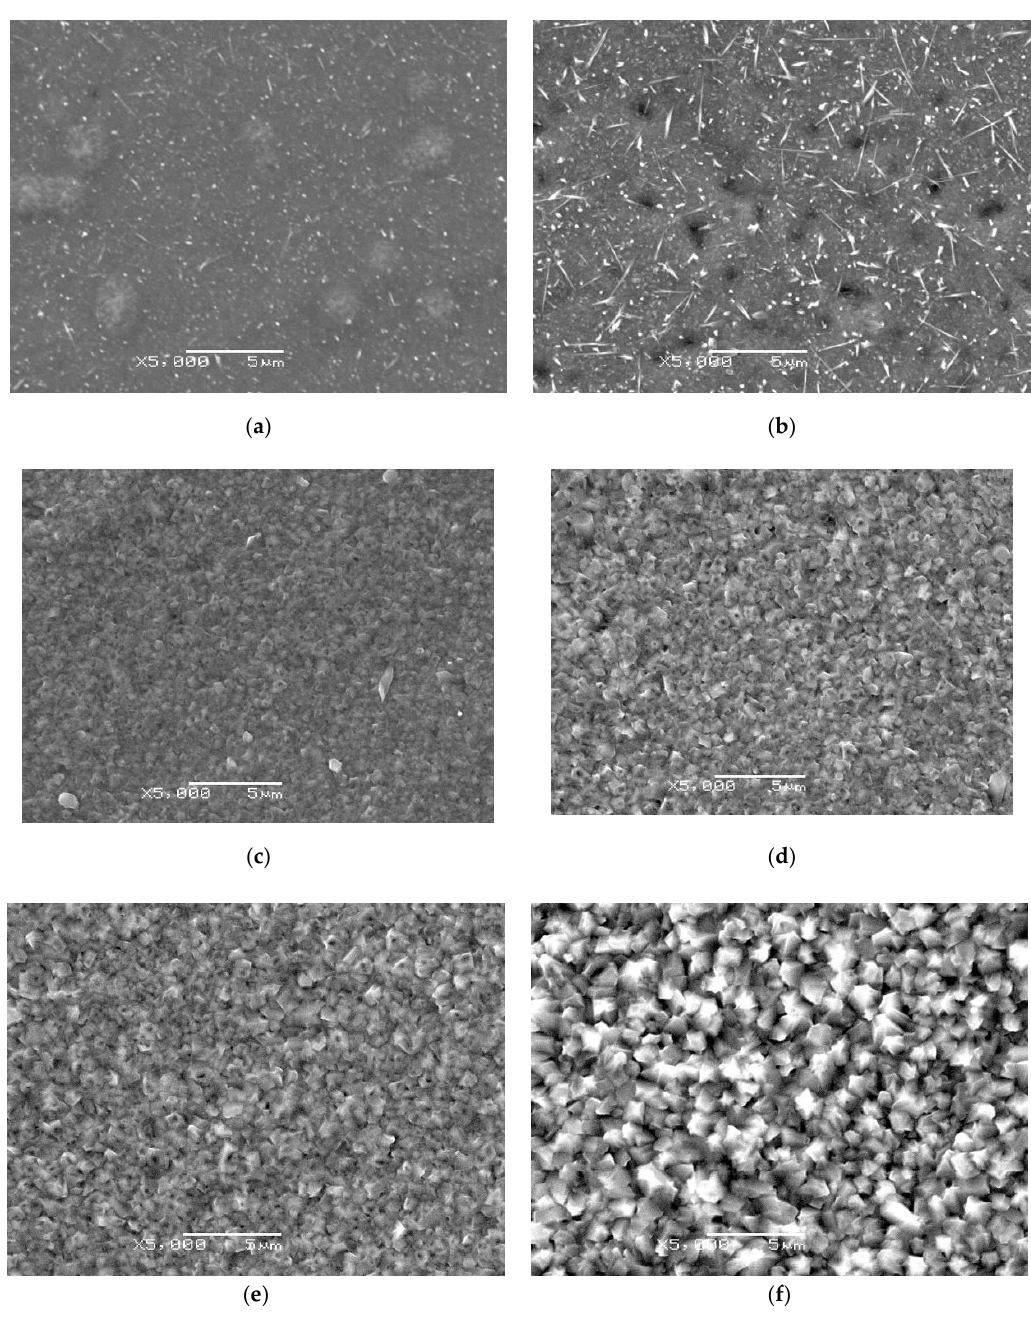
Figure 6. Morphology of the surface of titanium after cyclic oxidation at 600 °C (( a )—4 cycle/24 h, ( b )—12 cycle/72 h), 650 °C (( c )—4 cycle/24 h, ( d )—12 cycle/72 h) and 700 °C (( e )—4 cycle/24 h, ( f )—12 cycle/72 h).